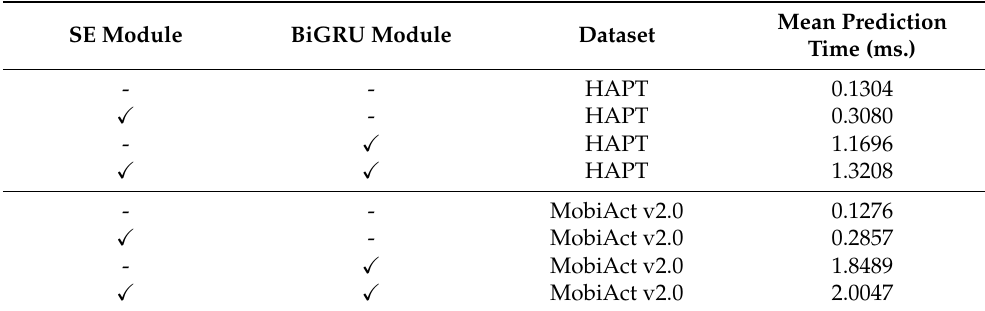
Table 9. Comparison of mean prediction times obtained from ResNet-based models with or without the SE and BiGRU modules. SE Module BiGRU Module Dataset